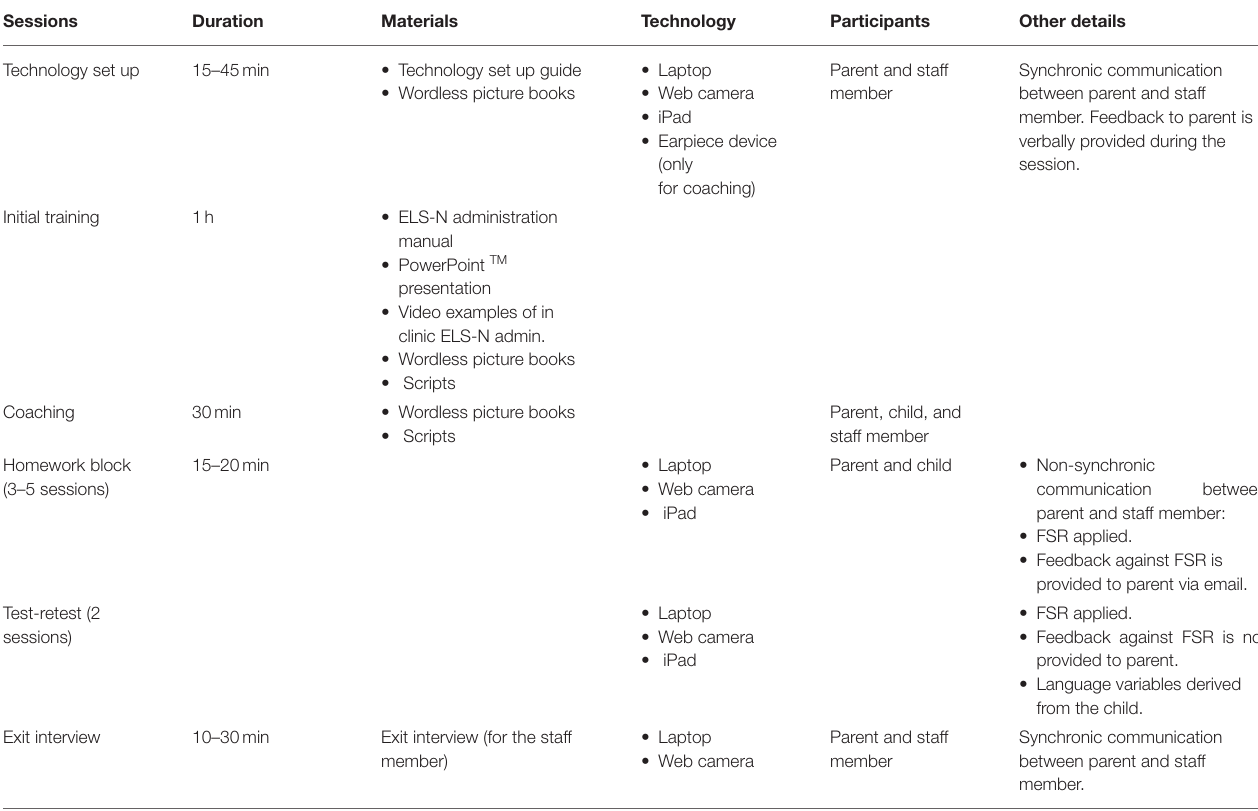
TABLE 3 | Key components of the parent training